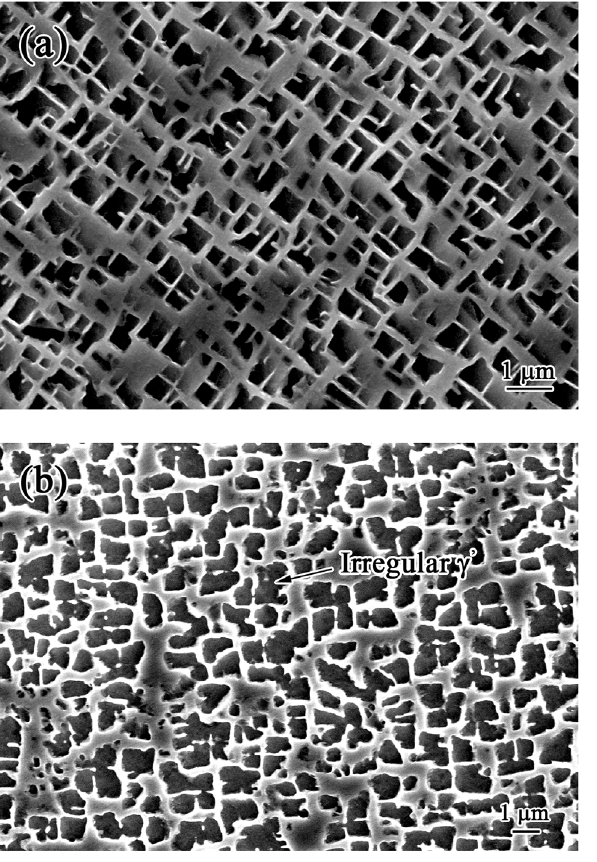
Figure 1: The γ ′ morphology for K002 superalloy. (a) Original micro- structure; (b) damaged microstructure.